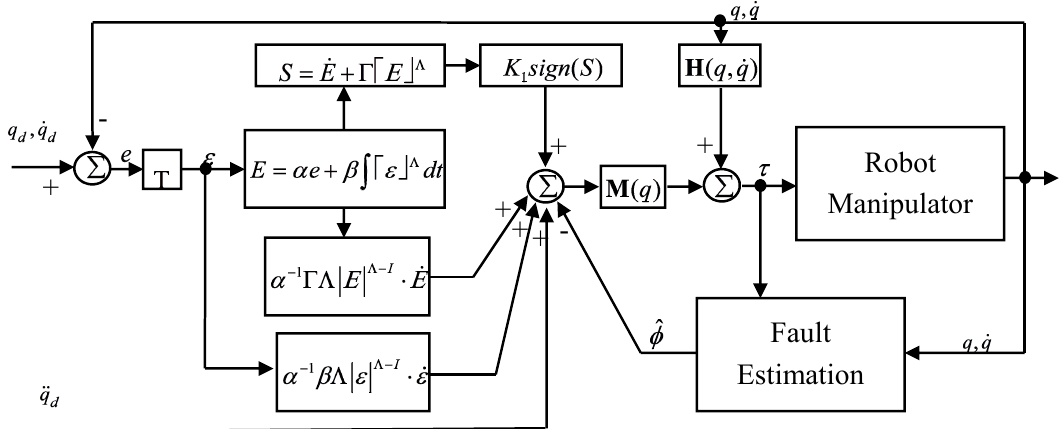
Figure 1. The block diagram of the proposed controller active fault-tolerant control with synchronous terminal sliding mode control 1 (AFTC-S-TSMC1).